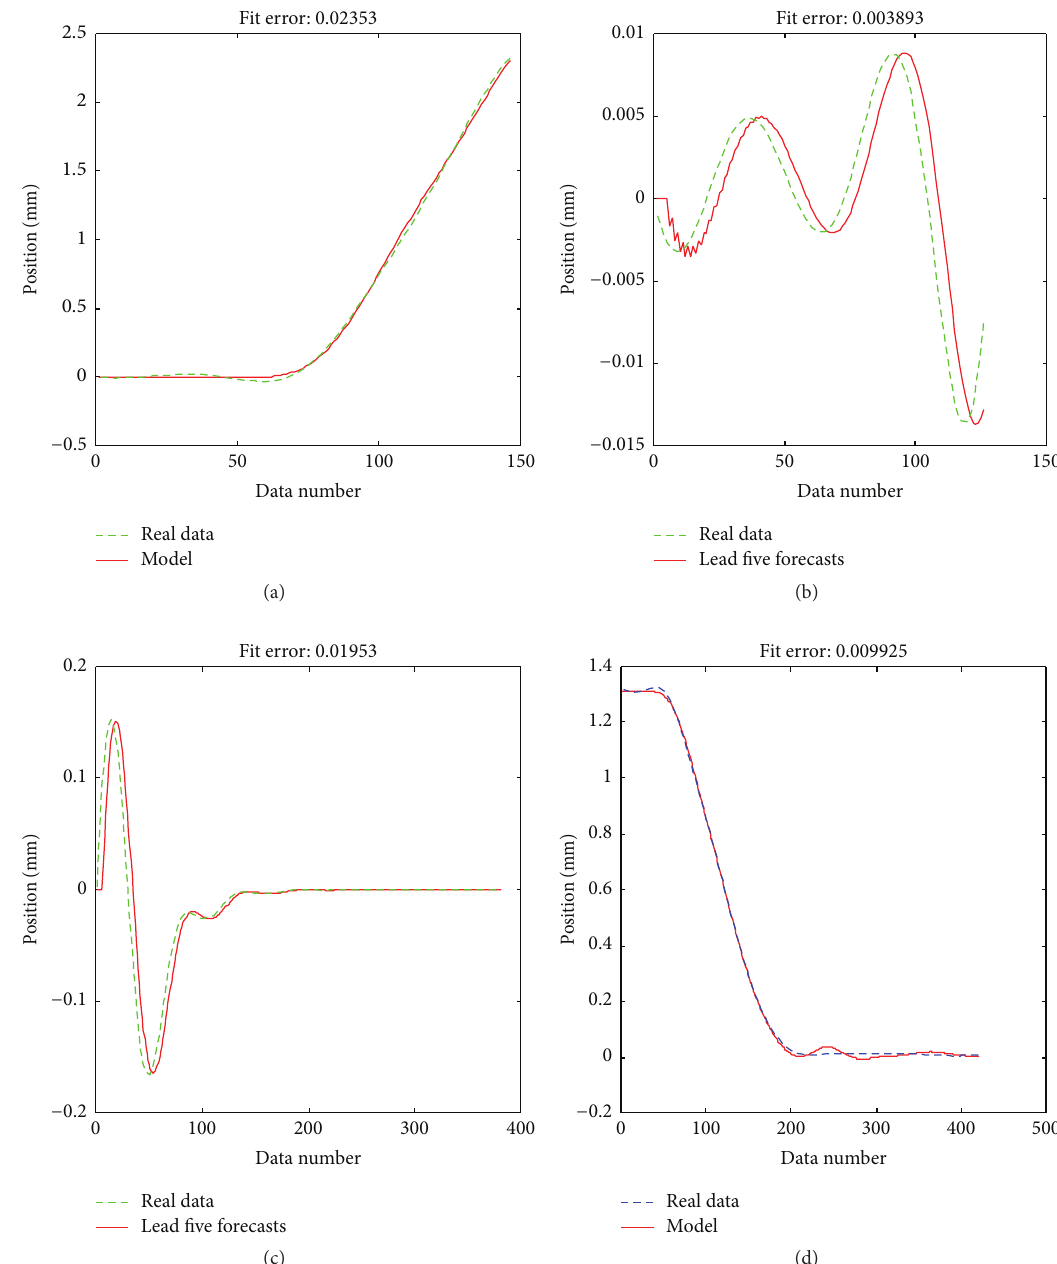
Figure 13: Model verification for the subsystem D for 120rpm operation speed: (a) section 1 , (b) section 2 , (c) section 3 , and (d) section 4 .